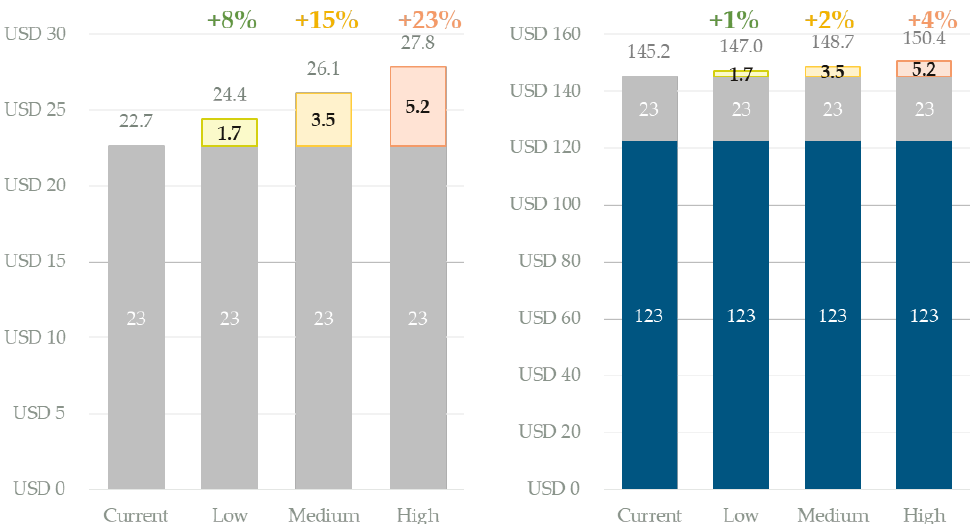
Figure 5. The impact of the carbon tax under various charging levels on freight rate ( left ) and trading price ( right ) for iron ore (assuming trades from Port Dampier, Australia to Qingdao, China). Notes: In October 2021, the highest freight rate and the average trading price for iron ore from Australia to China were 22.66 USD/ton and 122.58 USD/ton, respectively. Source: Shanghai Shipping Exchange.